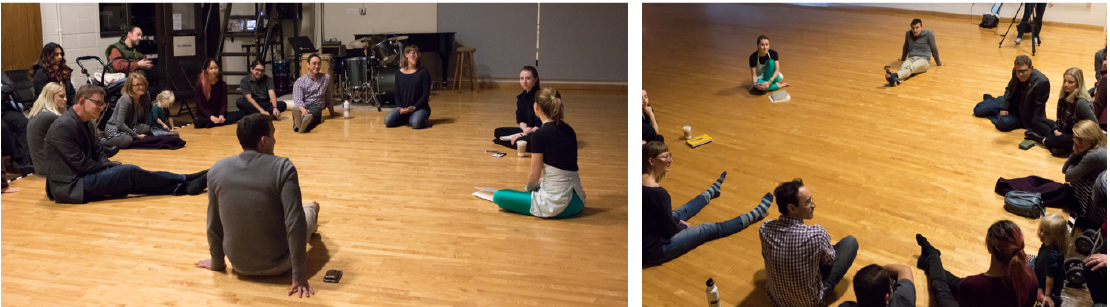
Figure 6. Audience members gathered for a post-show discussion. Photos by Natalie